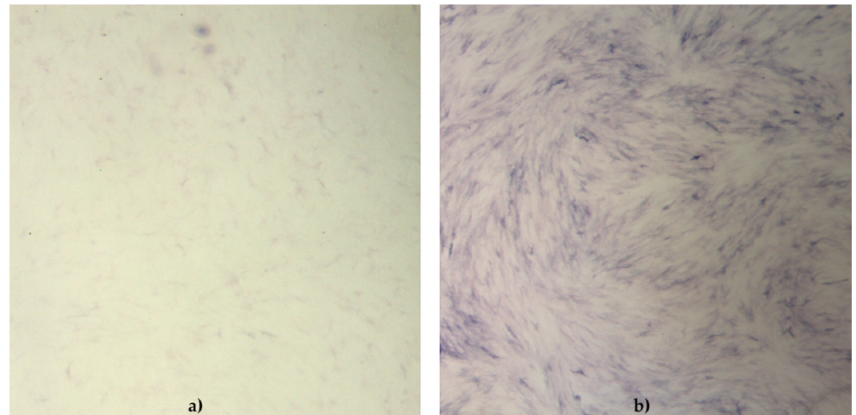
Figure 2. Functionality of canine adipose-derived mesenchymal stem cells (cAD-MSCs) demon- strated by successful differentiation into osteoblasts. Microscopic images (18×) of cAD-MSCs after osteodifferentiation. Cells were stained with SIGMAFAST(TM) BCIP (R)/NTB substrate to detect alkaline phosphatase activity. Cells were cultivated for 21 days in basal medium (negative control) ( a ) and stained with SIGMAFAST(TM) BCIP (R)/NTB, showing low-intensity staining. cAD-MSCs cultivated for 21 days in StemMACS OsteoDiff Media ( b ) and stained with SIGMAFAST(TM) BCIP (R)/NTB, showing high-intensity staining for alkaline phosphatase activity. The cells were examined under a stereomicroscope (Stereo Discovery, V20, CL1500 ECO, Zeiss).